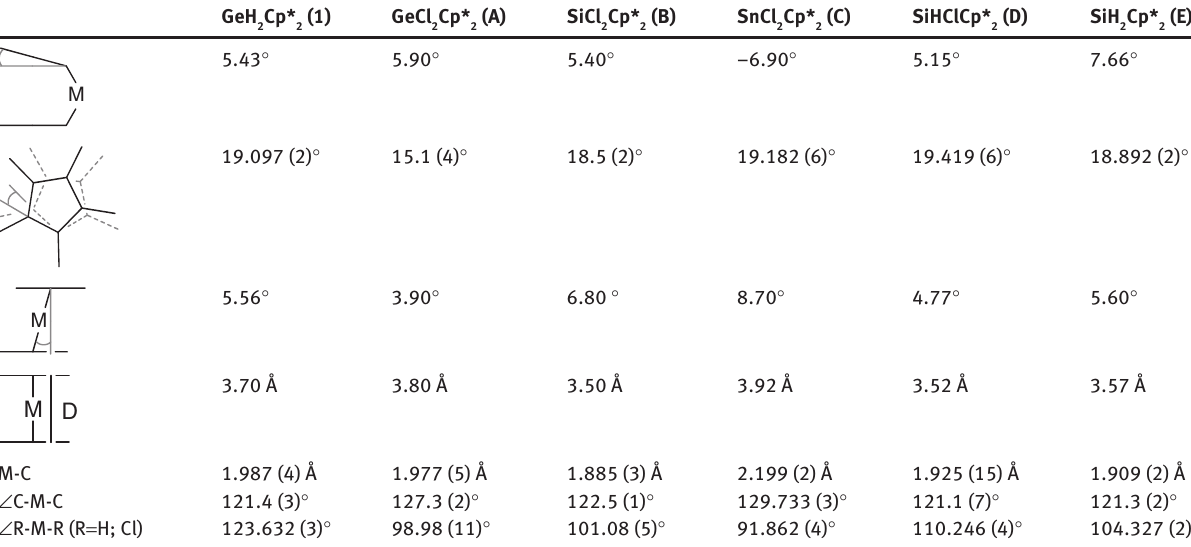
Table 1: Selected bond distances and angles of compounds 1 and A–E